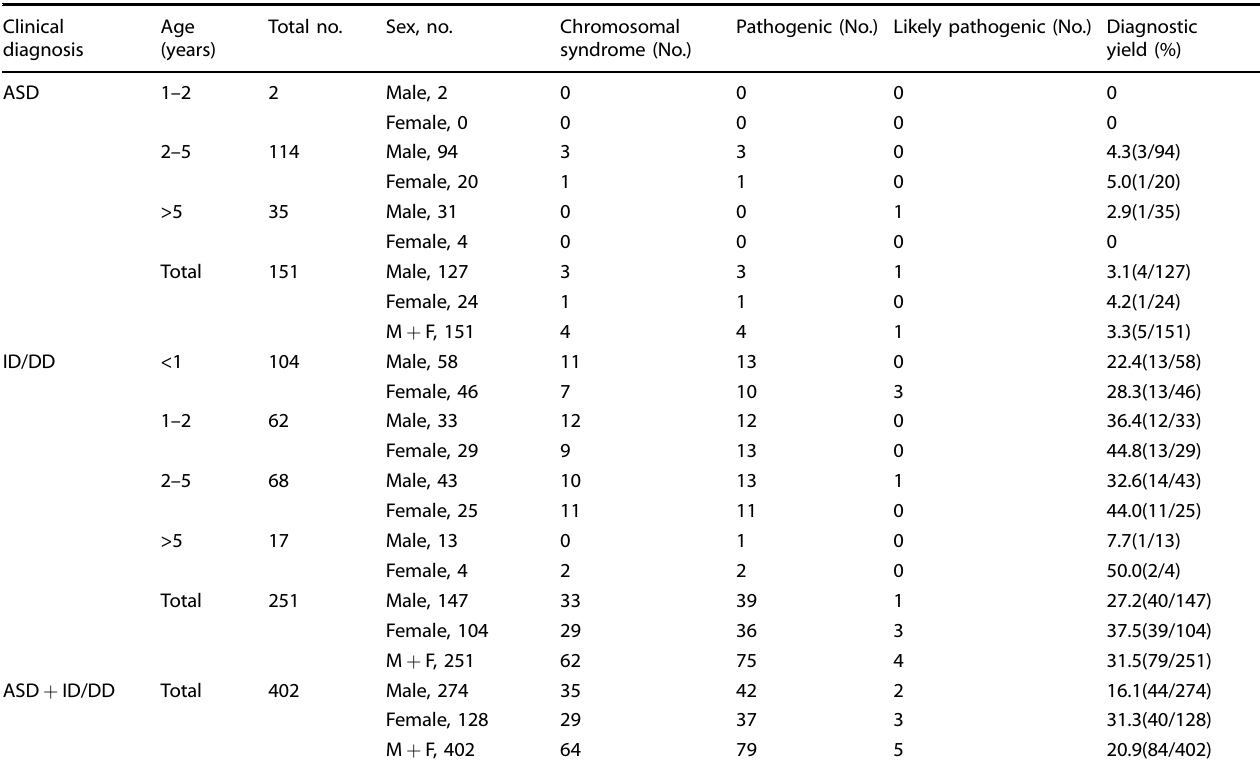
Table 1. Diagnostic yield of CNVs identi fi ed in the cohort. Clinical diagnosis